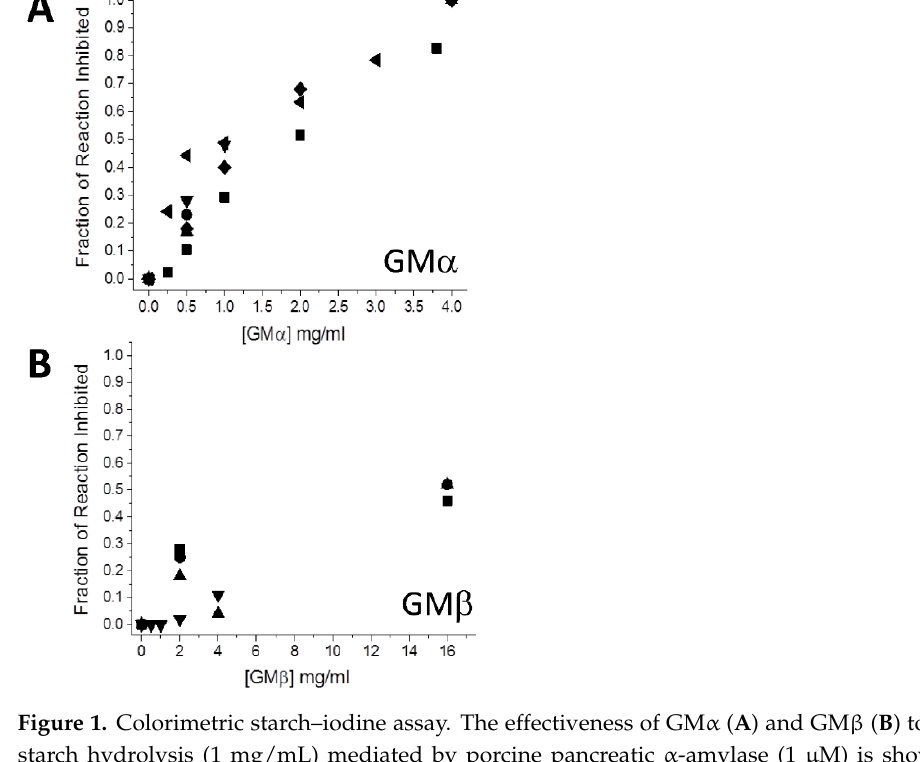
0.78 Figure 1 plots the fraction of reaction inhibition (rate with GM divided by rate without GM) vs. the concentration of GM α (Figure 1A) and GM β (Figure 1B), and Table 1 gives the average values of the individual data points shown in Figure 1. Results indicate that GM α is about 10 ‐ fold more effective than GM β . Because the composition of GM α and